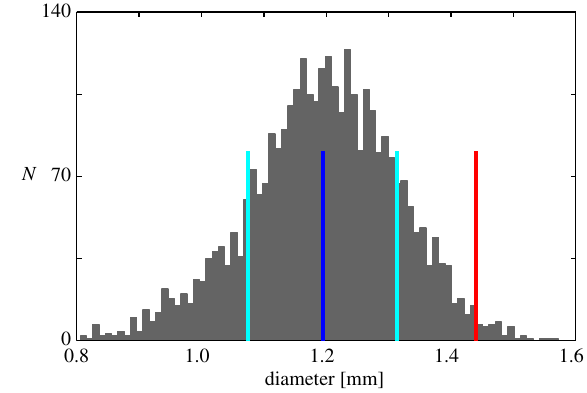
FIG. 5. The particles have mean diameter 1.19 mm with s.d. 0.12 mm (10% polydispersity). Here, we show the particle-size distribution with the mean (vertical blue line) and the mean (cid:2) 1 s.d. (vertical cyan lines). The gap between the glass disks is 1.44 mm (vertical red line), or 2 s.d. above the mean, confining the particles to a monolayer without restricting their in-plane motion. This histogram is measured optically from a sample of about 3230